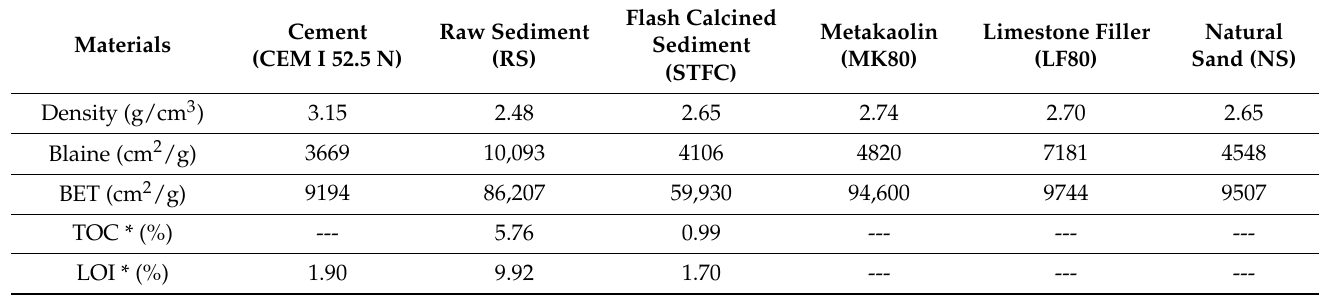
Table 2. Determination of the physical properties of the materials.